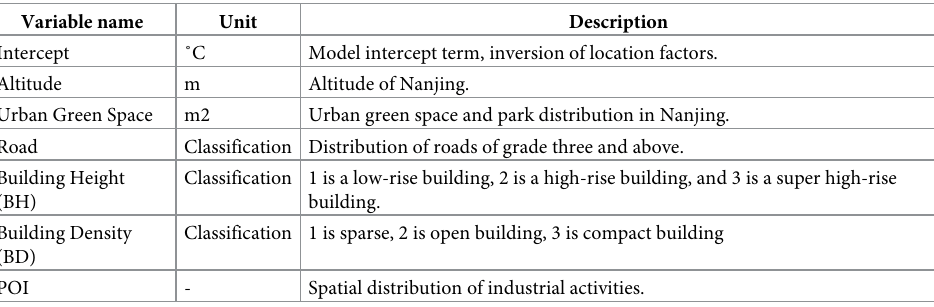
Table 2. Descriptions of major explanatory variables.